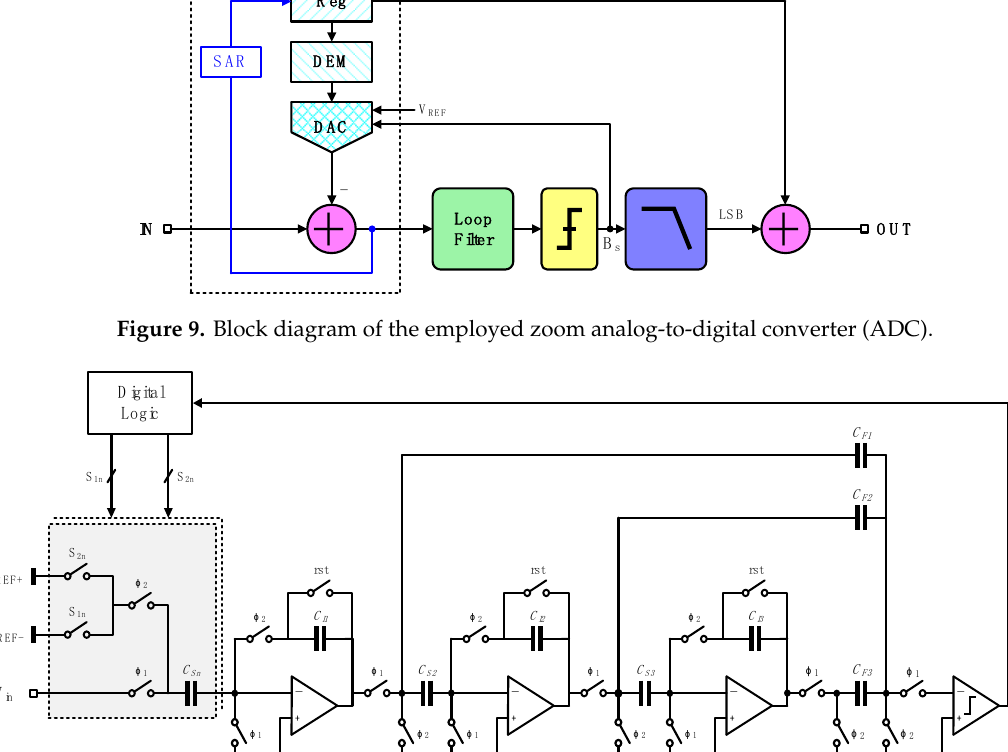
Figure 9. Block diagram of the employed zoom analog-to-digital converter (ADC).